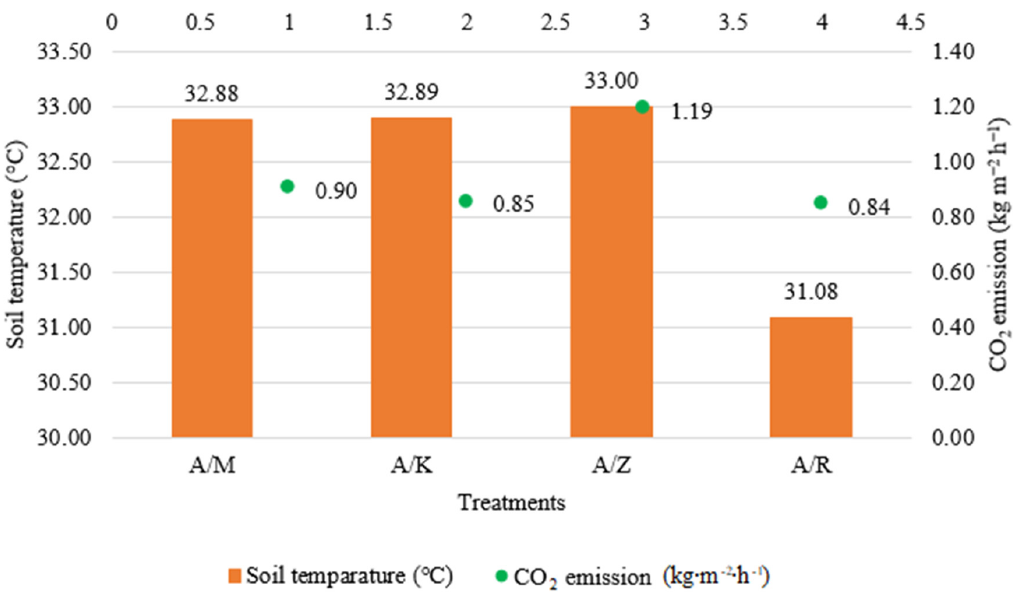
Figure 9. Average results of soil temperature ( ◦ C), CO 2 -emission (kg · m − 2 · h − 1 ) by treatment on 28 July 2020 (Karcag). Note: A/Z: Unused/abandonment grassland treatment; A/M: mulch treatment; A/K: Mowing treatment; A/R: